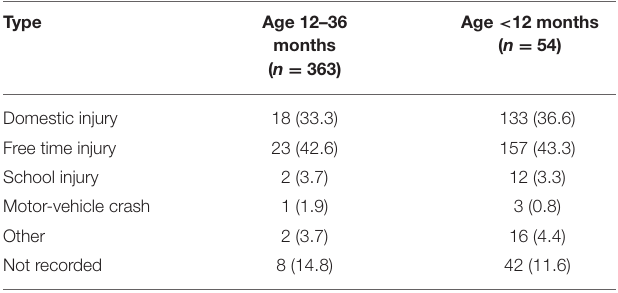
TABLE 2 | Type of history reported by the parents for the occurrence of skeletal fractures (SFs) at Emergency Room (ER) admission according to patient’s age.